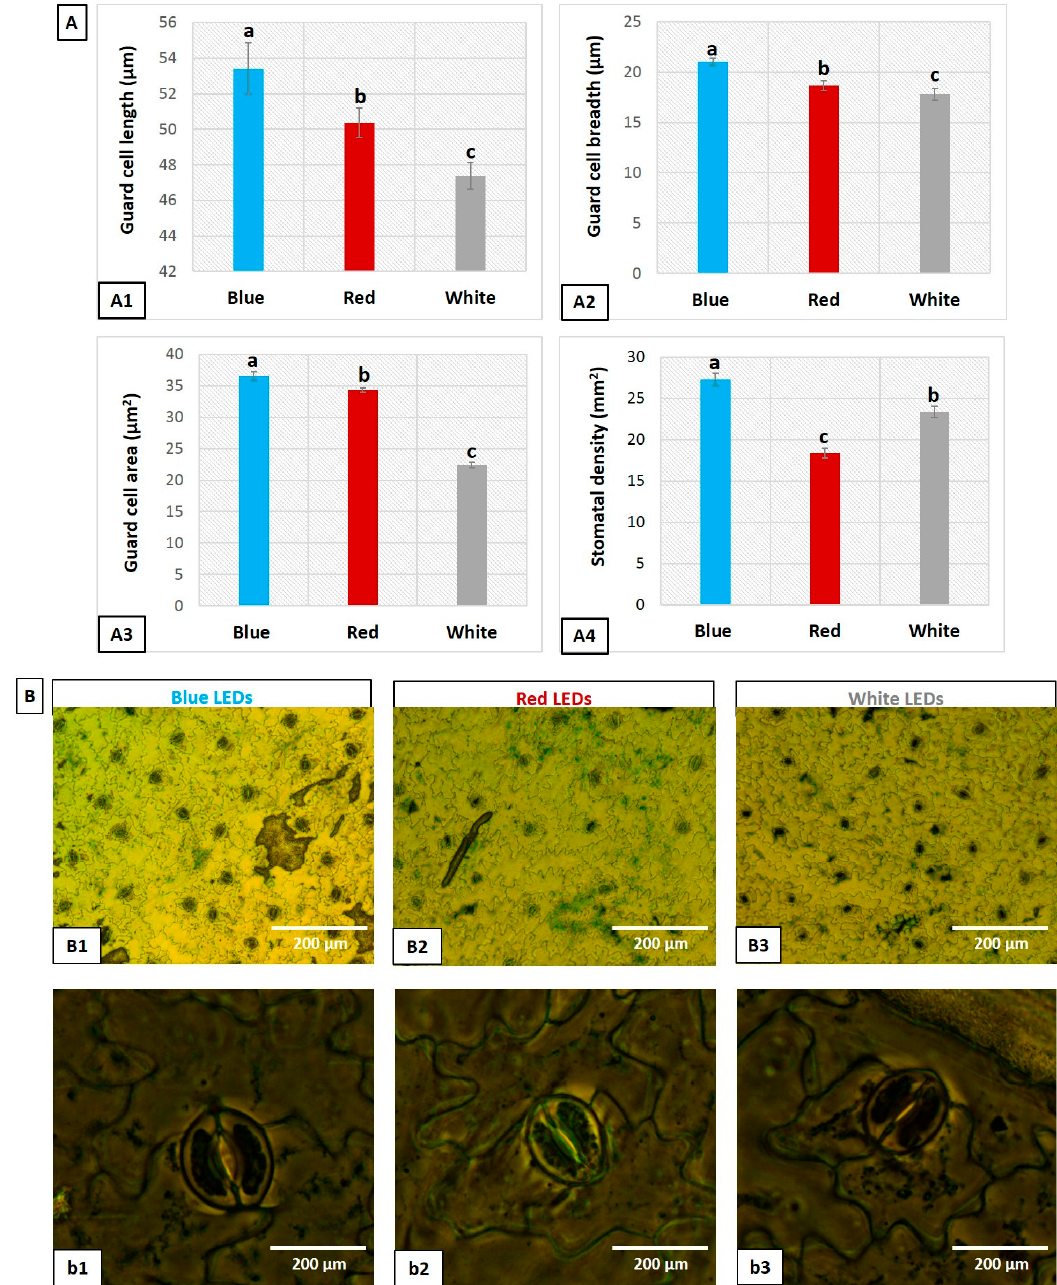
Figure 5. Effect of B, R, and W LED light on stomatal characteristics of the abaxial layer of Eustoma leaves. ( A1 ), guard cell length ( µ m); ( A2 ), guard cell breadth ( µ m); ( A3 ), guard cell area ( µ m 2 ); and ( A4 ), stomatal density (mm 2 ). Distribution and anatomical parameters of the stomata in the abaxial epidermal layer of Eustoma leaves using blue, red, and white LEDs from representative cross-sections. ( B1 , b1 ), blue; ( B2 , b2 ), red; and ( B3 , b3 ), white LED light. Data are mean values ( n = 10), the vertical bars represent ± SE, and means are separated by Tukey’s HSD at P < 0.05.